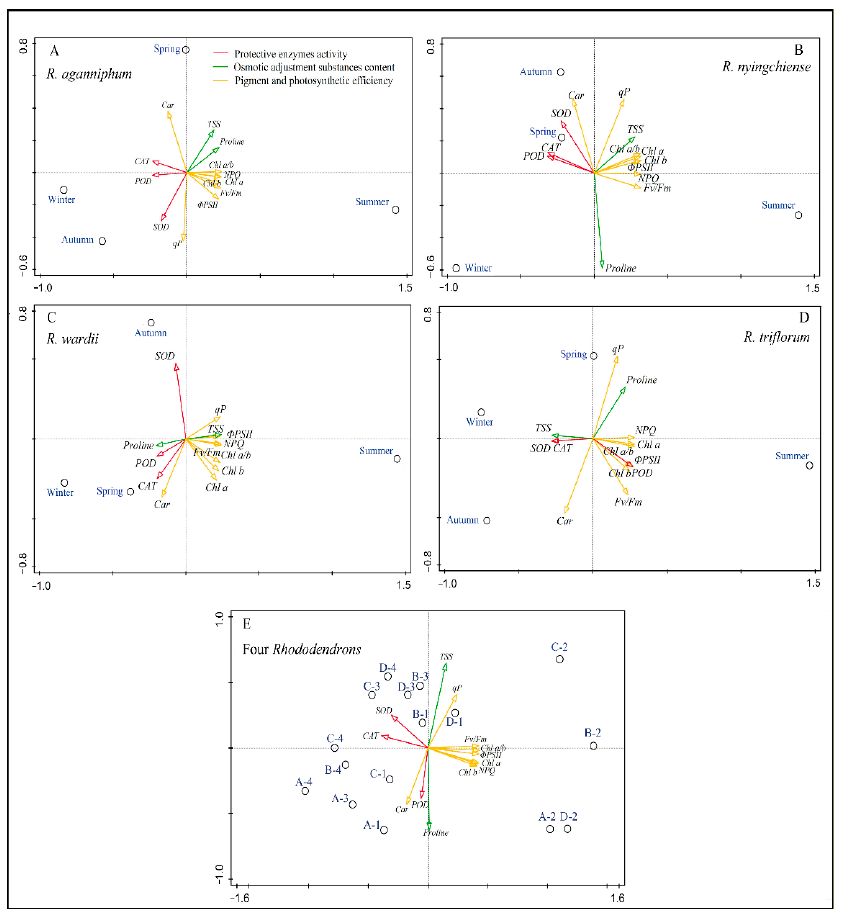
Figure 5. Principal component analysis (PCA) on the correlation matrix of 13 eco-physiological indicators (SOD, POD, CAT, proline, TSS, chl a, chl b, chl a/b, car, Fv/Fm , Φ PSII, qP, NPQ) in spring ( A ), summer ( B ), autumn ( C ), and winter ( D ) in subalpine habitat, respectively. The hollow circles represent each species in each season. ( E ) represents the PCA output on the basis of the 13 eco- physiological indicators of all Rhododendrons that were studied in four seasons. Letters A, B, C, and D in front of the short dash indicate R. aganniphum , R. nyingchiense , R. wardii , and R. triflorum , re- spectively, while numbers 1, 2, 3, and 4 after the short dash indicate spring, summer, autumn, and winter, respectively.